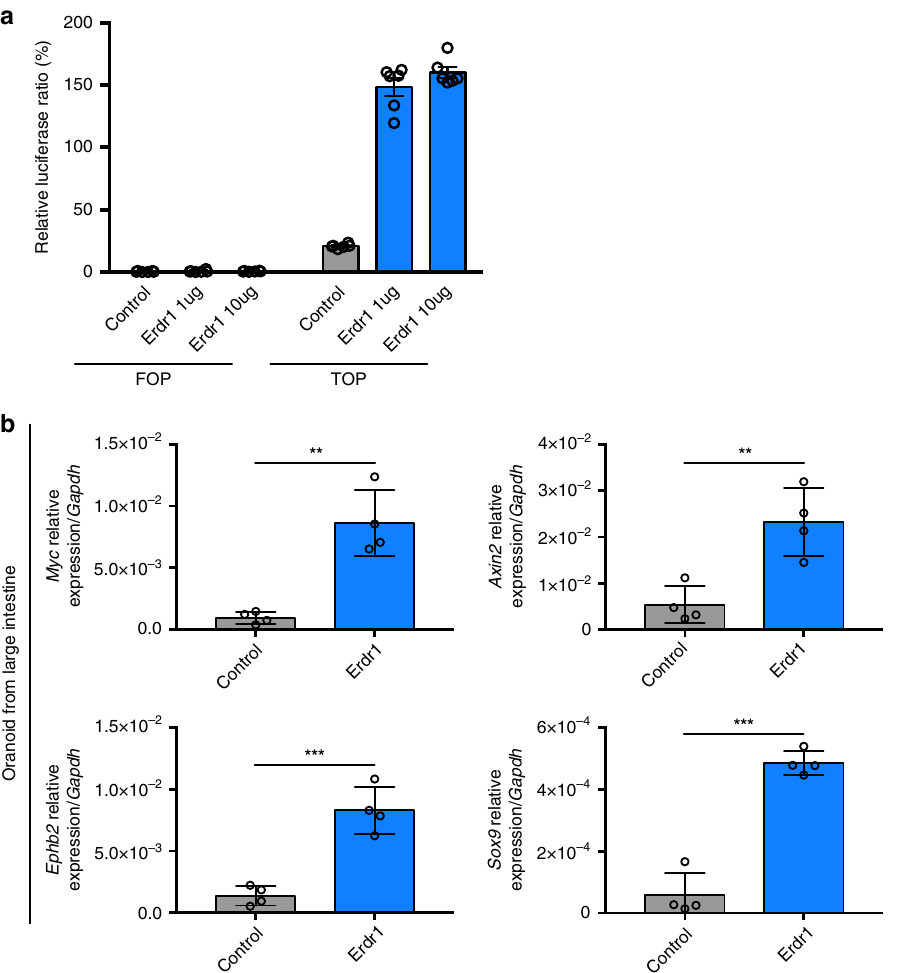
Fig. 5 Erdr1 enhances Wnt signaling in intestinal epithelial cells and organoids. a The relative luciferase activity measured by the TOP/FOP- fl ash assay in SKCO-15 human intestinal epithelial cells stimulated ±Erdr1. n = 6; representative of two experiments. b Expression of Wnt signaling pathway target genes ( Myc , Axin2 , Ephb2 , Sox9 ) in LI organoid cultures ±Erdr1 (1 μ g/mL). n = 4; representative of three experiments. All data are presented as mean ± SD; * P < 0.05, ** P < 0.01, *** P < 0.001 by unpaired, two-tailed t